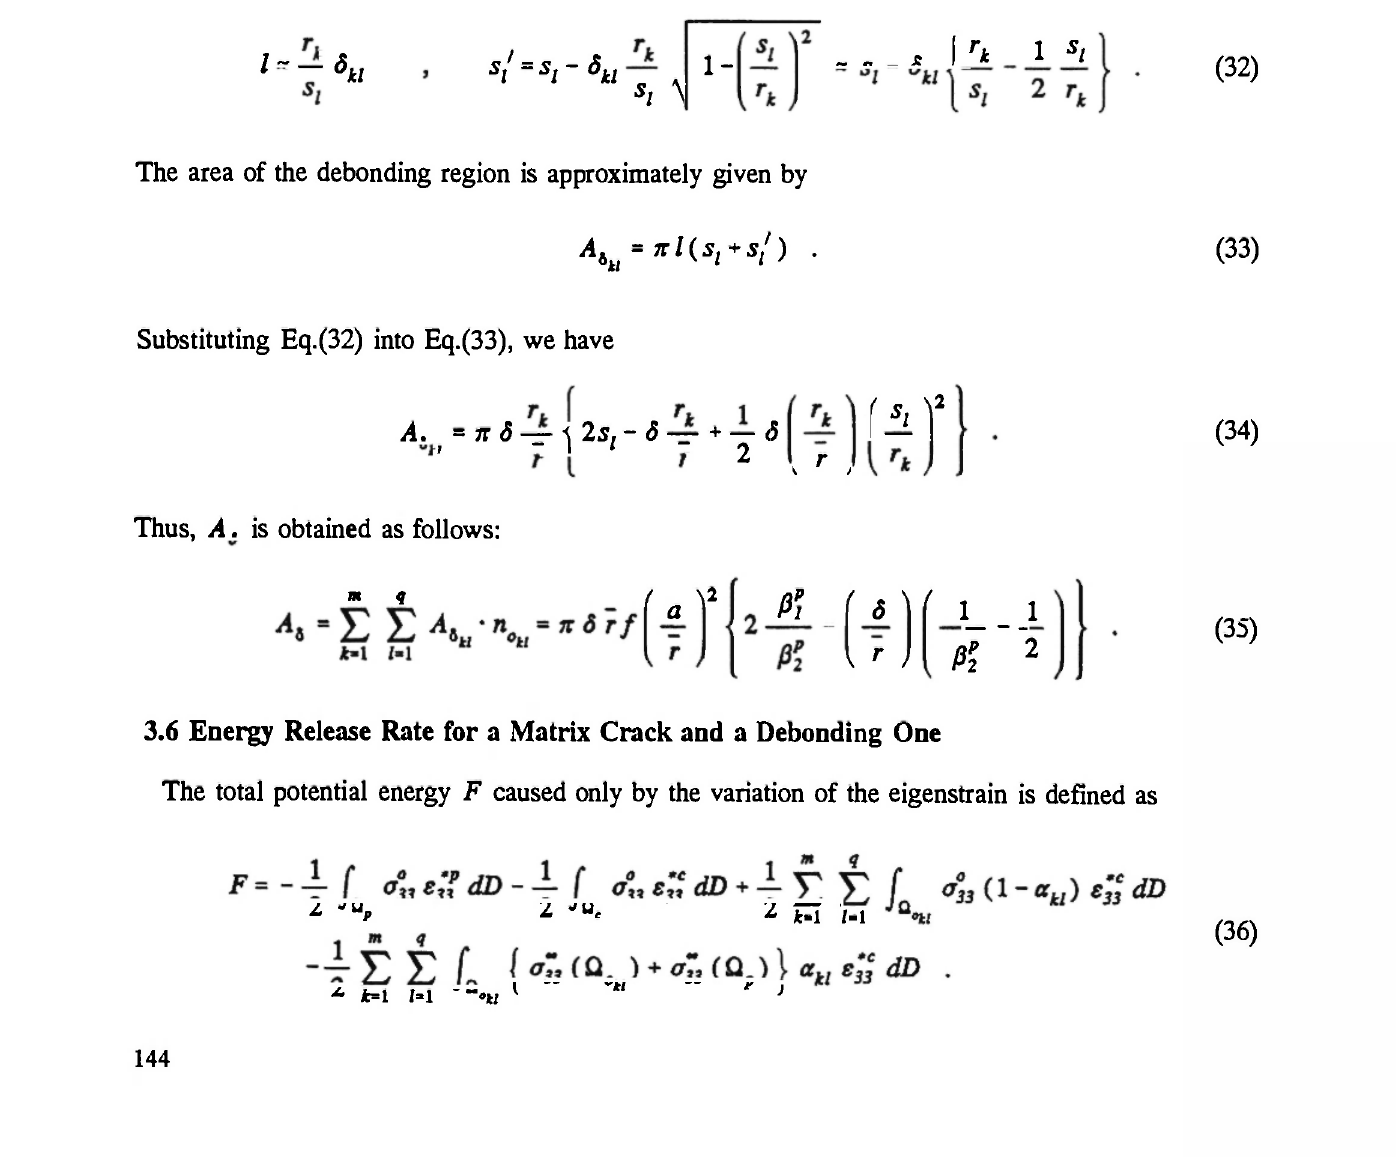
Fig.4 Geometry of the debonding area of a